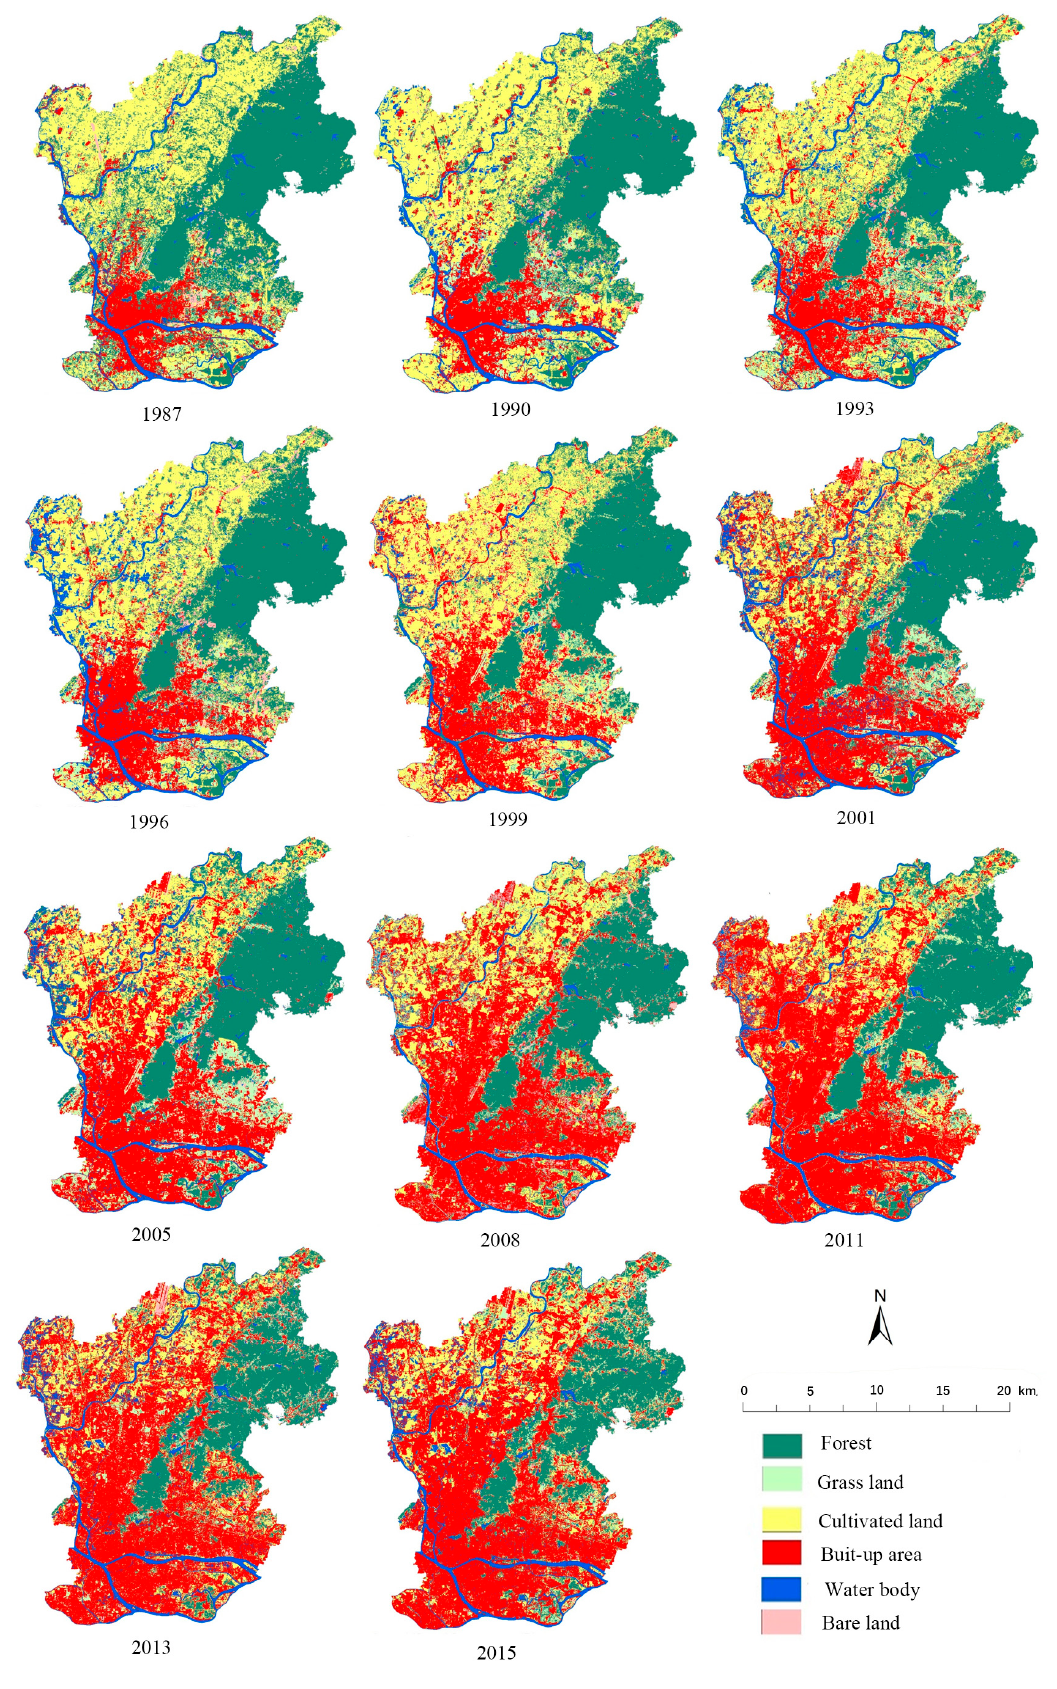
Figure 6. Land use/cover maps for the Guangzhou metropolitan area from 1987 to 2015.